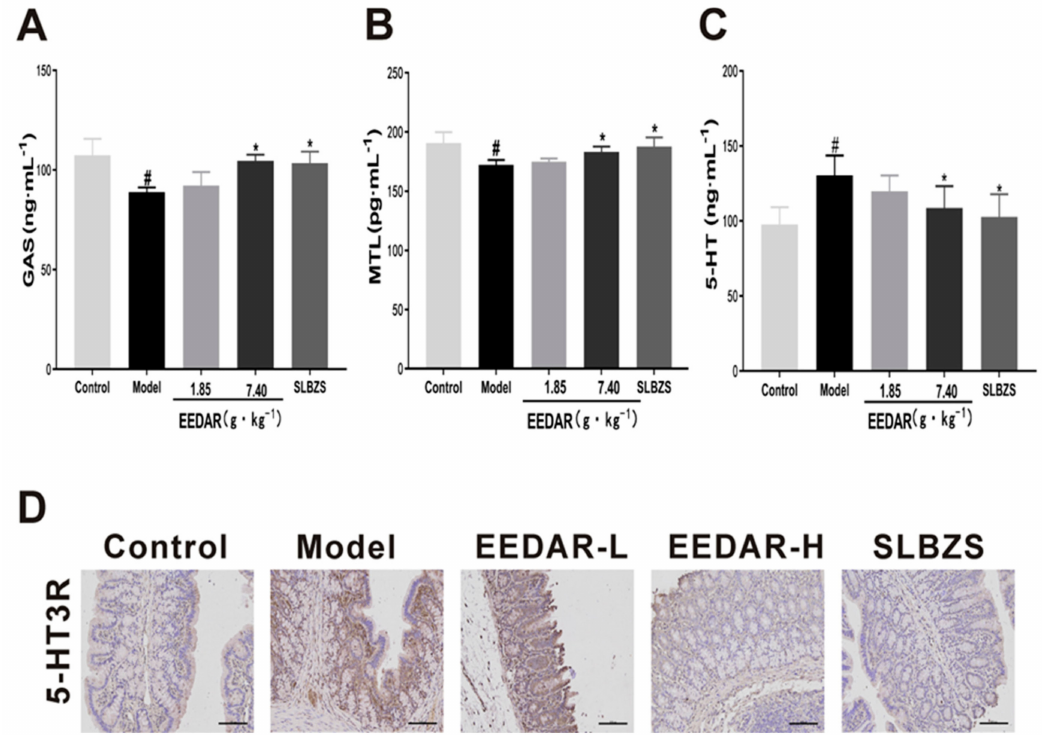
Figure 3. E ff ect of EEDAR on gastrointestinal motility hormone, serotonin, and its receptor in spleen-deficiency diarrhea rats ( n = 10). Levels of GAS ( A ), MTL ( B ), and 5-HT ( C ) in serum were measured by ELISA. Representative images of 5-HTR3 ( D ) and IHC sections (200 × magnification) from colons indicating di ff erent pathological changes in spleen deficiency diarrhea rats when treated with EEDAR-L (1.85 g · kg − 1 ), EEDAR-H (7.40 g · kg − 1 ), and SLBZS. Values represent means ± SEM. # p < 0.05 vs. Control; * p < 0.05 vs. Model. (Scale bar